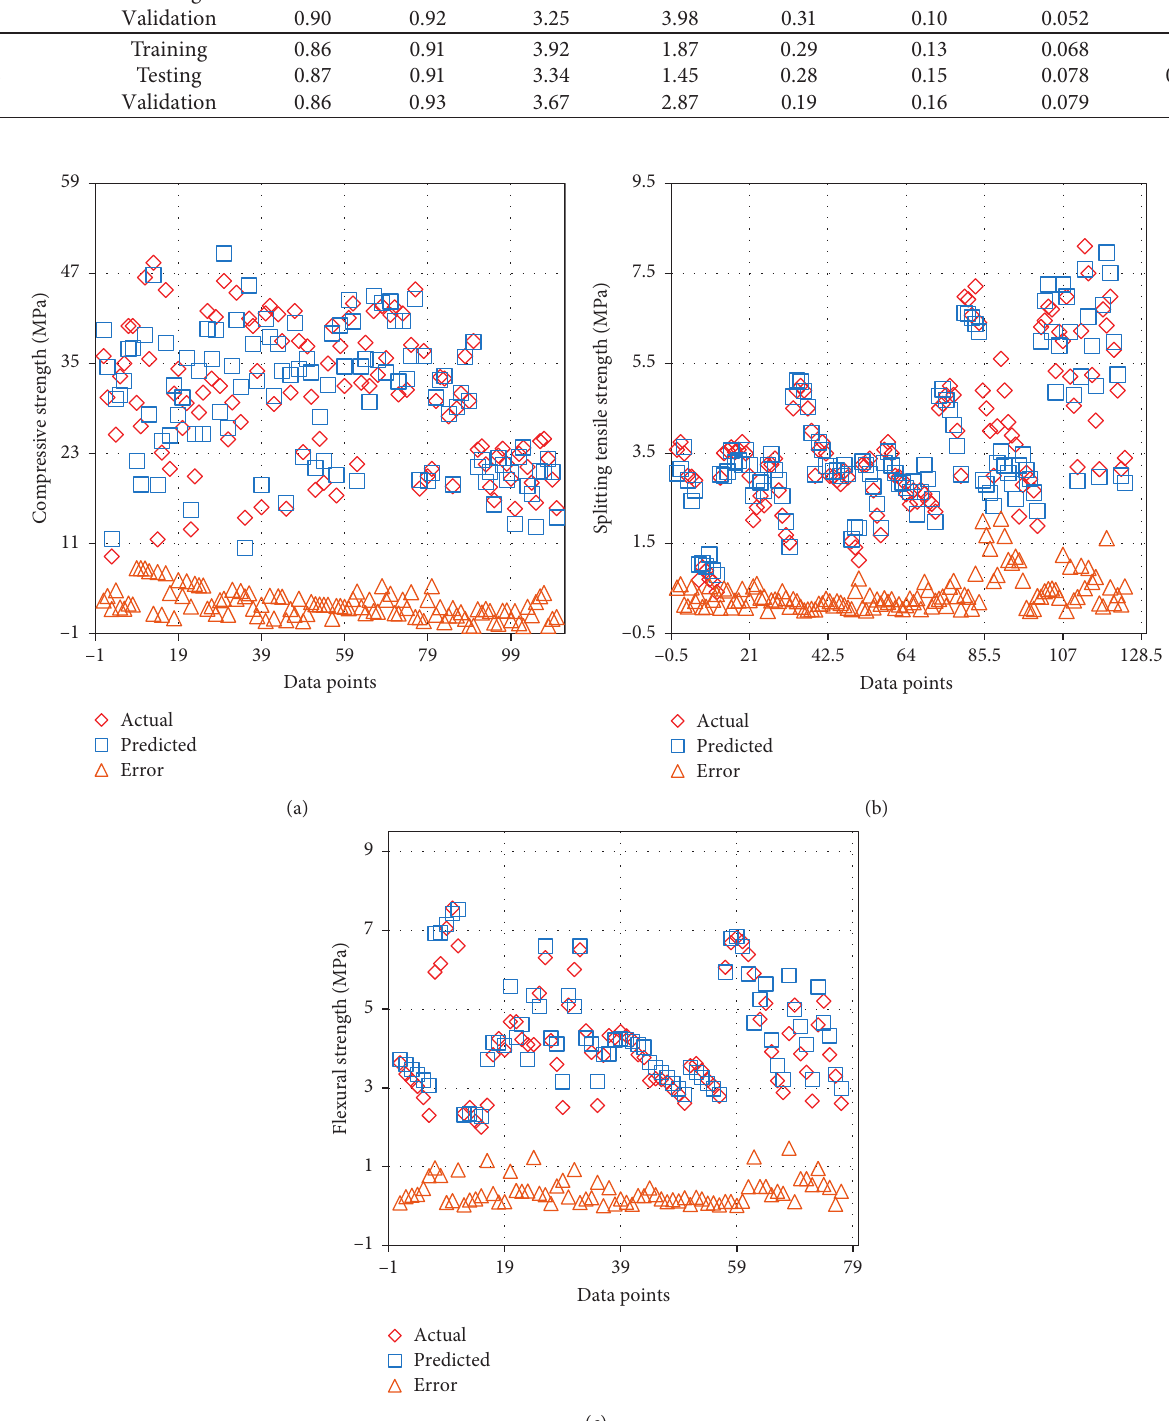
Figure 7: Description of the error among the actual and predicted data: (a) CS; (b) ST; (c)